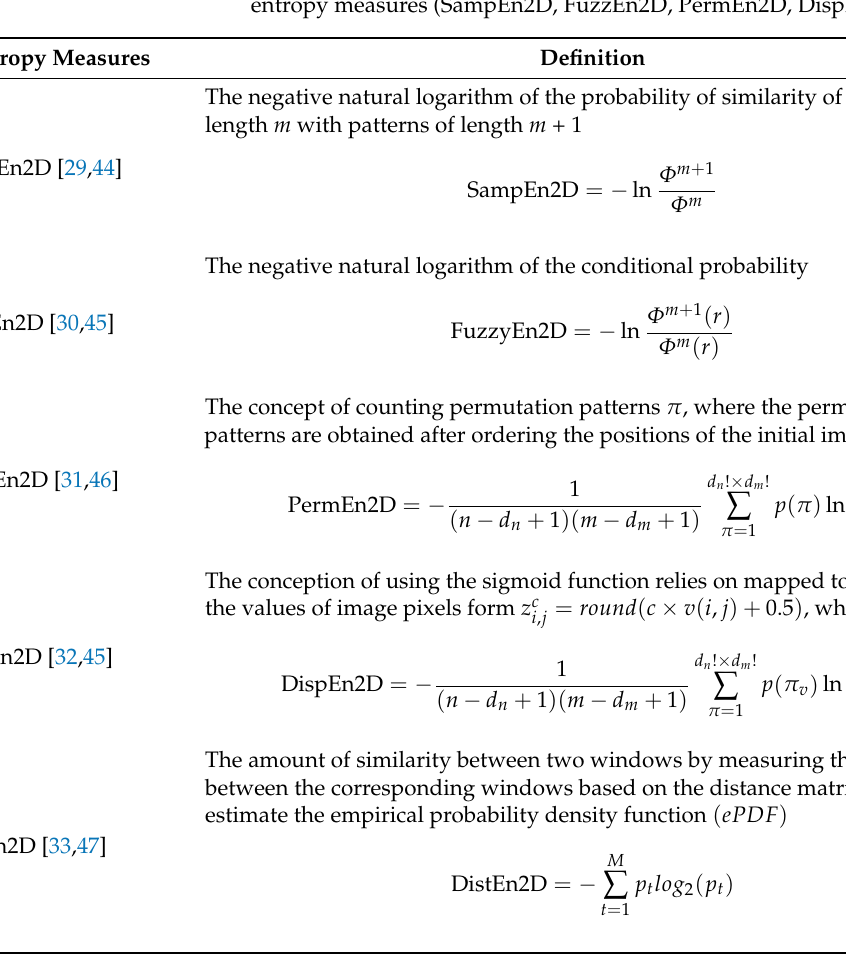
Table 2. The comparison of details (definition, relations between the values and the irregularity/complexity of the image, and application of measures) of